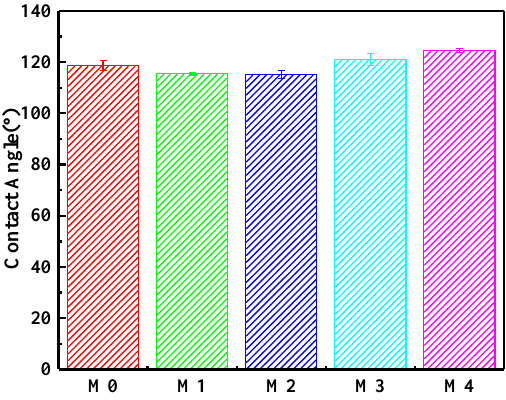
Figure 5. Influence of DBP/DOP ratio on the static water contact angle. Materials 2018 , 11 , 443